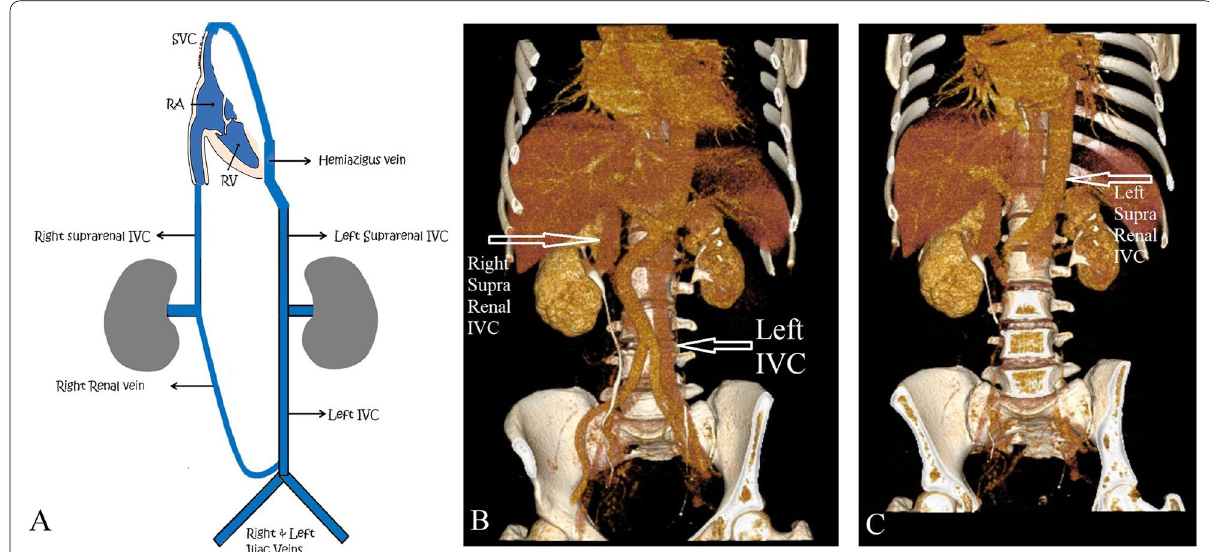
Fig. 1 The image A illustrates the schematic anatomy of the patient’s IVC and B , C are reconstructed images of patient’s CT venography, IVC, Inferior vena cava; RA, Right atrium; RV, Right ventricle; SVC, Superior vena